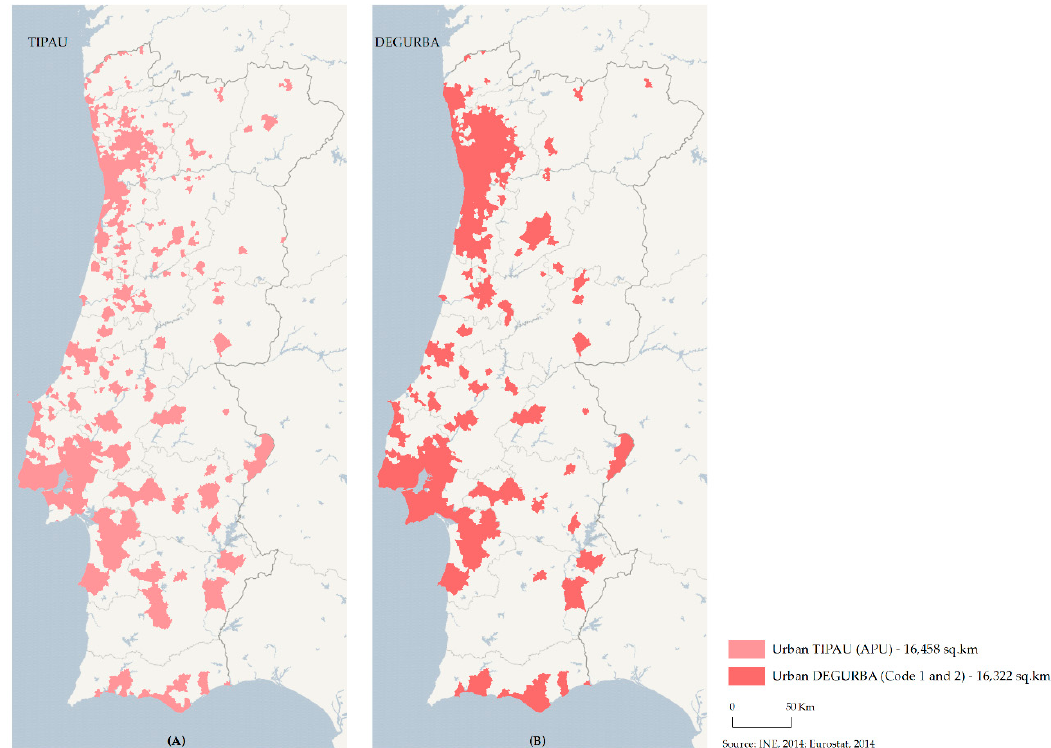
Figure 5. Urban areas according to administrative delimitations LAU2 (parishes) ( A ) TIPAU 2014 (APU); ( B ) DEGURBA 2014 (Code 1 and Code 2).